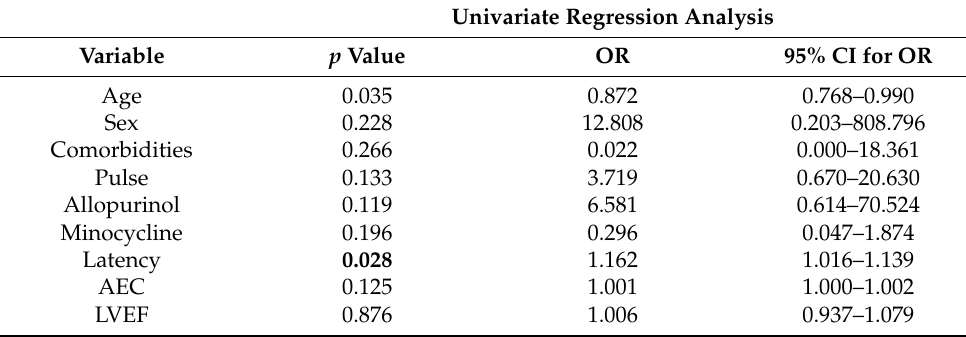
Table 2. Regression analysis in prediction of patients’